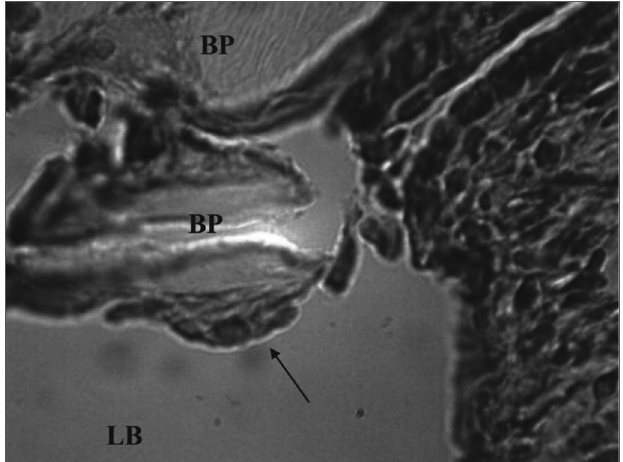
Figure 3. Experimental group chronic reaction - Microphotography of a sugar cane biopolymer membrane having been engulfed by giant cells; foreign body type; BP= sugar cane biopolymer. LB= bulla lumen. Thin arrow =giant cell. HE (1000x magnification).